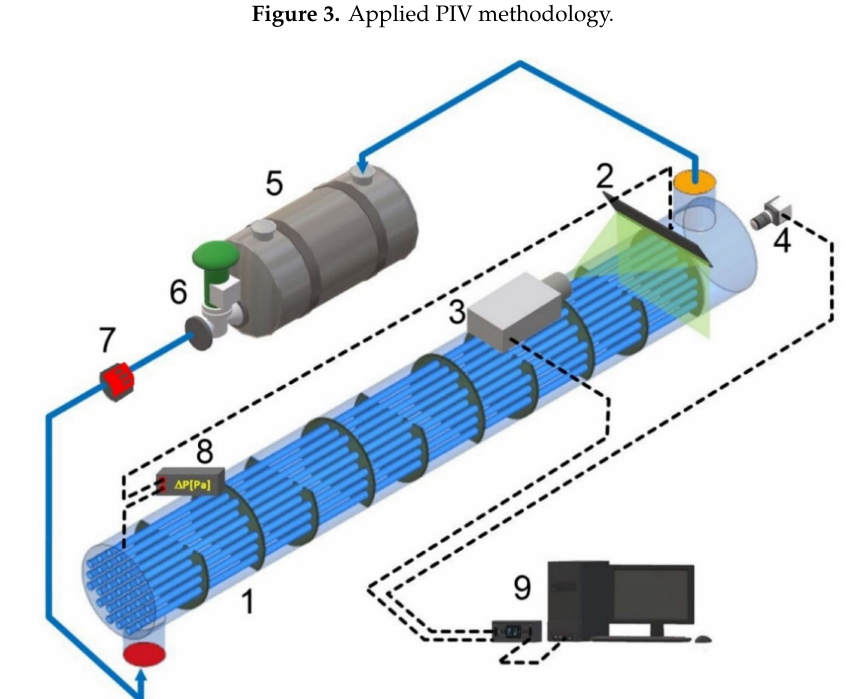
Figure 4. Experimental stand: shell-and-tube heat exchanger model ( 1 ), mirror ( 2 ), laser ( 3 ), CCD camera ( 4 ), tank ( 5 ), pump ( 6 ), flowmeter ( 7 ), di ff erential pressure transmitter ( 8 ), and control and data acquisition station ( 9